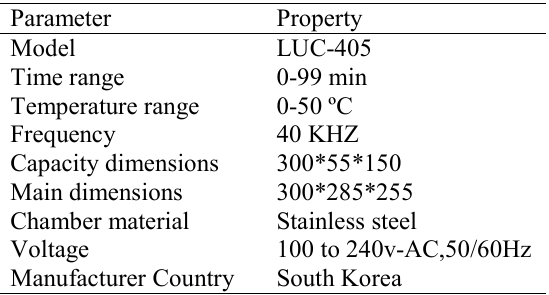
Table 1. Ultrasonic device specifications